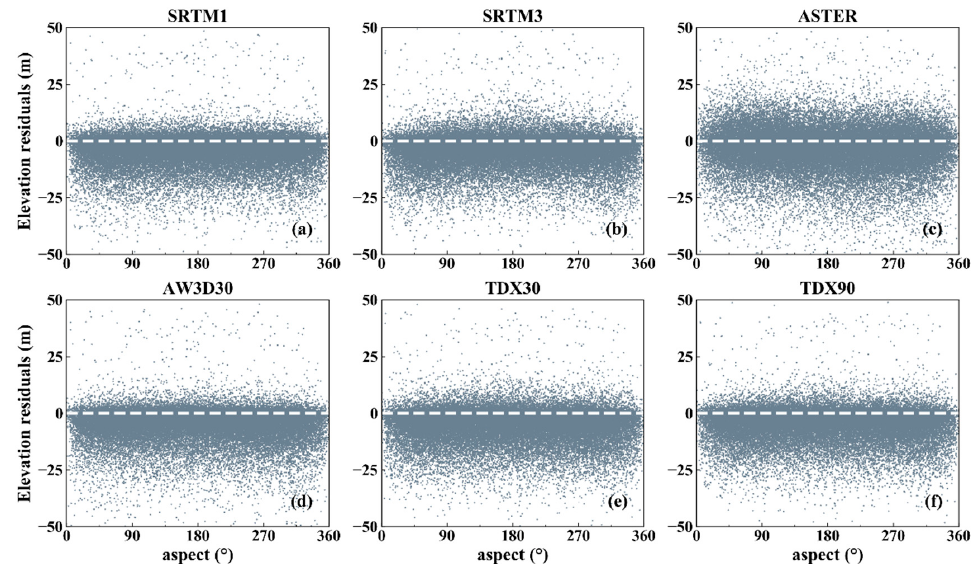
Figure 6. The scatter plots between DEM error and terrain aspect for ( a ) SRTM1; ( b ) SRTM3; ( c ) ASTER; ( d ) AW3D30; ( e ) TDX30 and ( f ) TDX90. ( d ) AW3D30; ( e ) TDX30 and ( f ) TDX90.